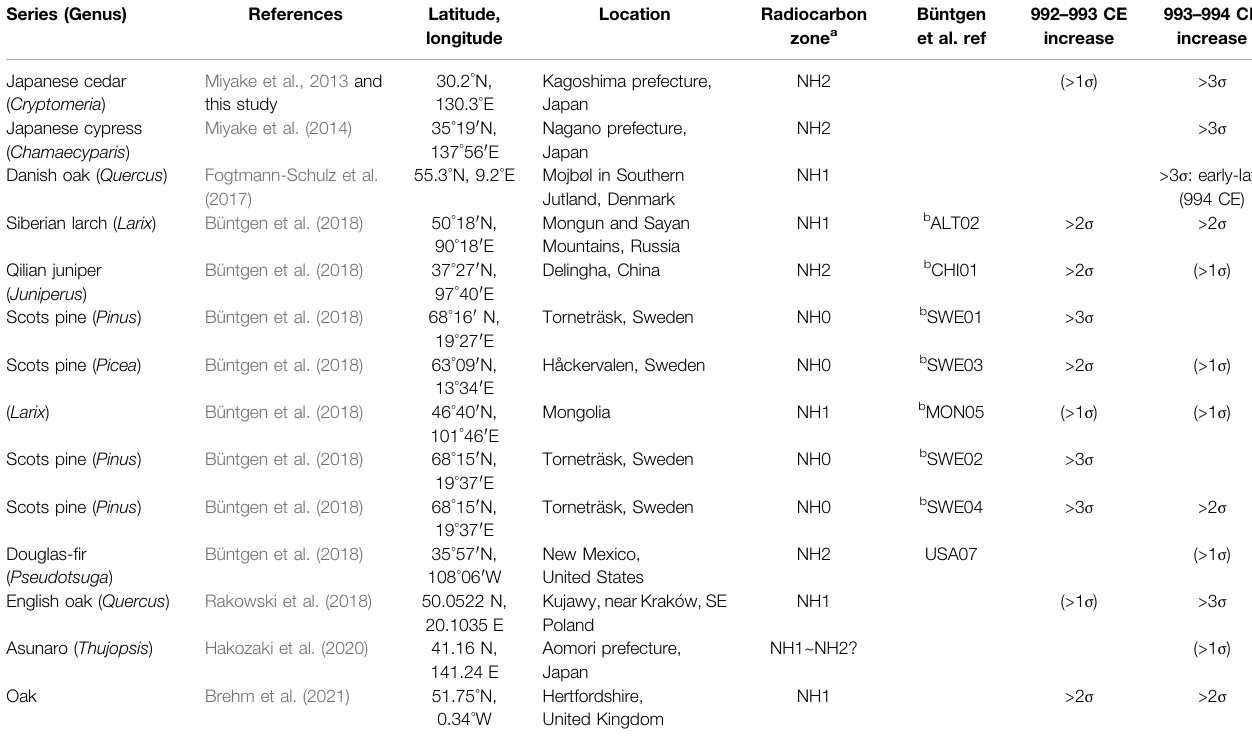
TABLE 1 | Available 14 C datasets for the 993 CE event (Northern Hemisphere). For columns, the 992 – 993 CE increase and 993 – 994 CE increase, σ indicates error propagationof Δ 14 Cincrease I ( > 1 σ , > 2 σ ,and > 3 σ denote1 σ < I ≤ 2 σ ,2 σ < I ≤ 3 σ ,and I > 3 σ ,respectively).Theincreasesofmore than1 σ ( > 1 σ )areshownasareference in the table, though we did not consider them as signi fi cant